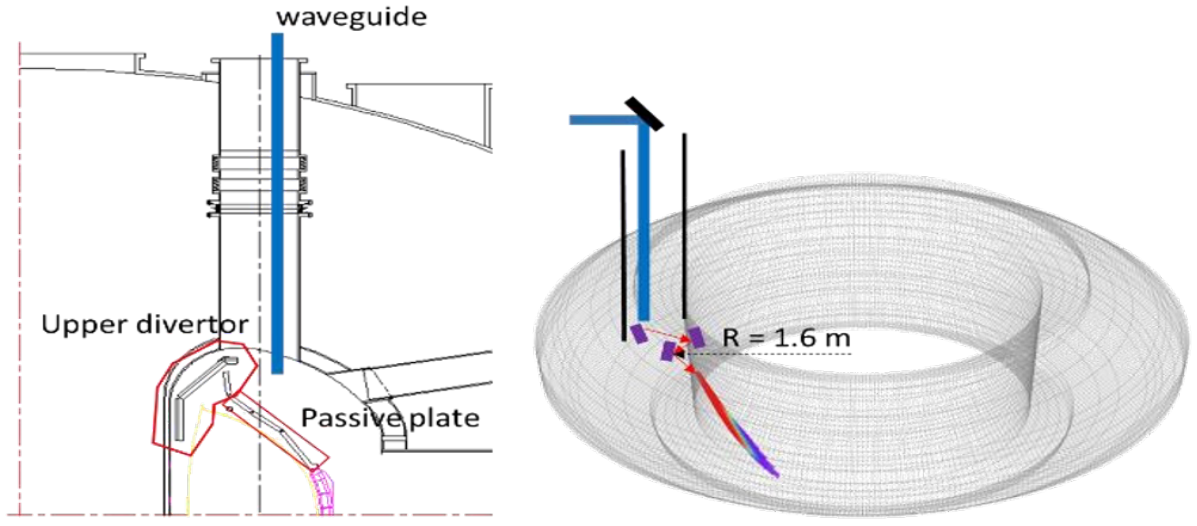
Fig. 11. The interface of the vertical top launche with upper divertor and passive plate and the conceptual drawing of the waveguide insertion and three